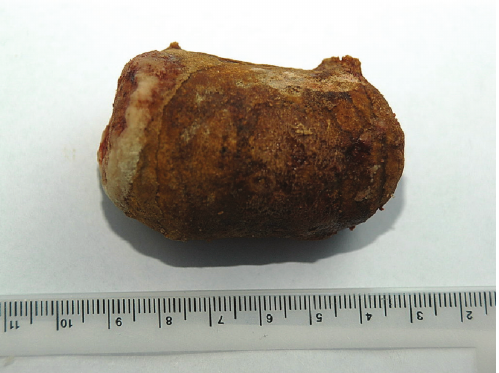
Figure 3: A giant ureter stone.